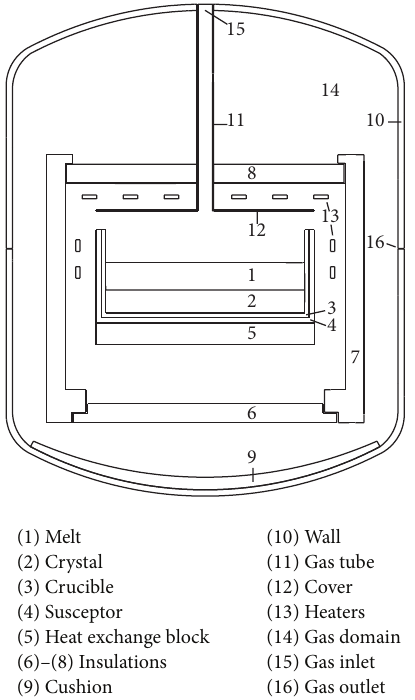
Figure 1: Configuration of an industrial directional solidification